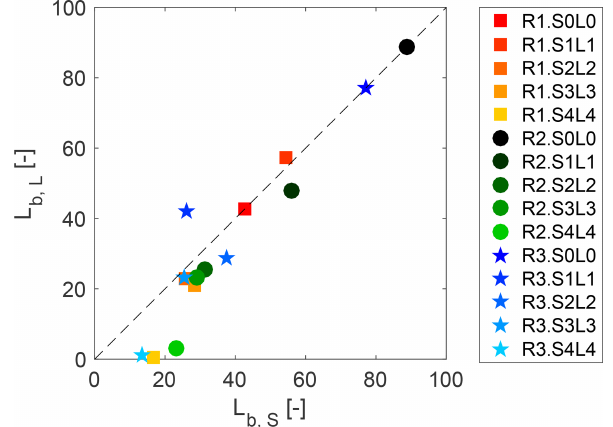
Figure 11. Comparison of (cid:56) m , a surrogate for the entrainment ca- pacity of the mixing region, between tests with lock slope ( S i ) and correspondent tests on a horizontal bottom ( L i ). The dashed line is the identity